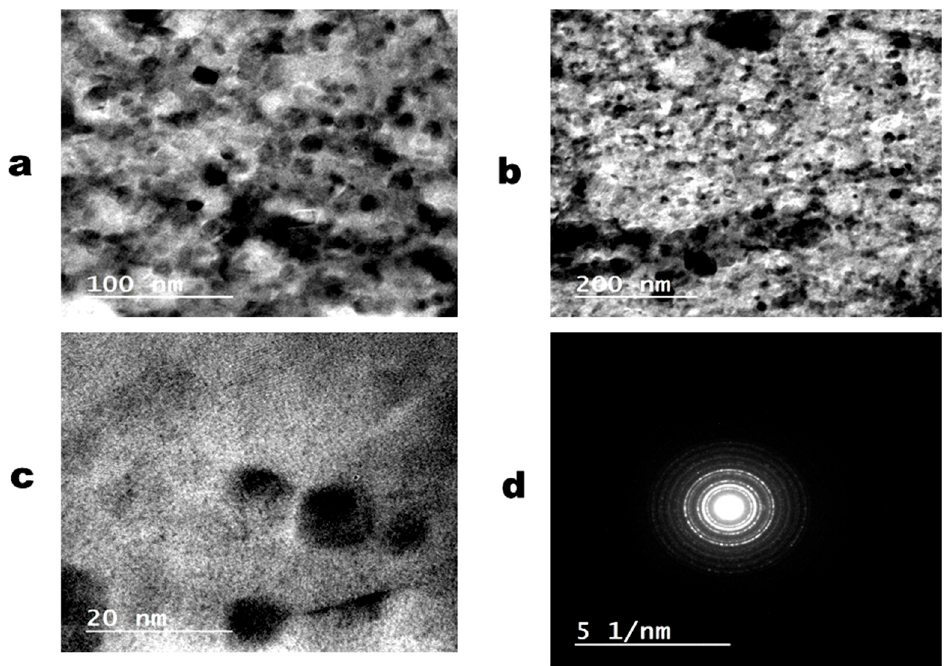
Figure 3. ( a , b ) various magnifications, and ( c , d ) selected-area electron diffraction transmission electron micrograph (TEM) images of S2 samples.